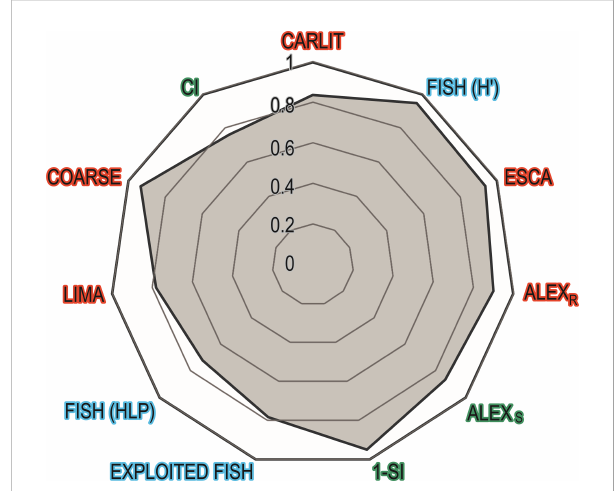
FIGURE 2 Polygon resulting from the EQR scores of all the indices (grey shape). An ideal hendecagon (white polygon) is shown below as a reference. Colors refer to the different habitat/biotic components (blue: fi sh; red: reef; green: seagrass) for which indices provide